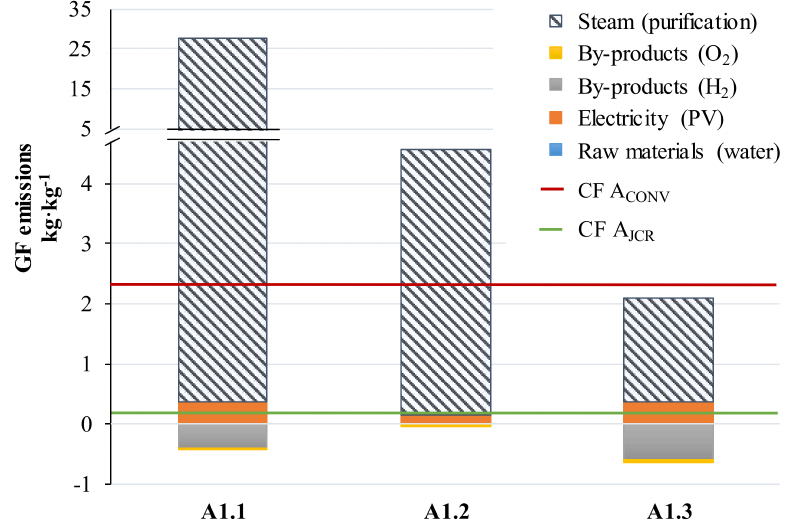
Figure 3. CF values for the selected scenarios (functional unit is 1 kg of FA at a commercial concentration of 85%